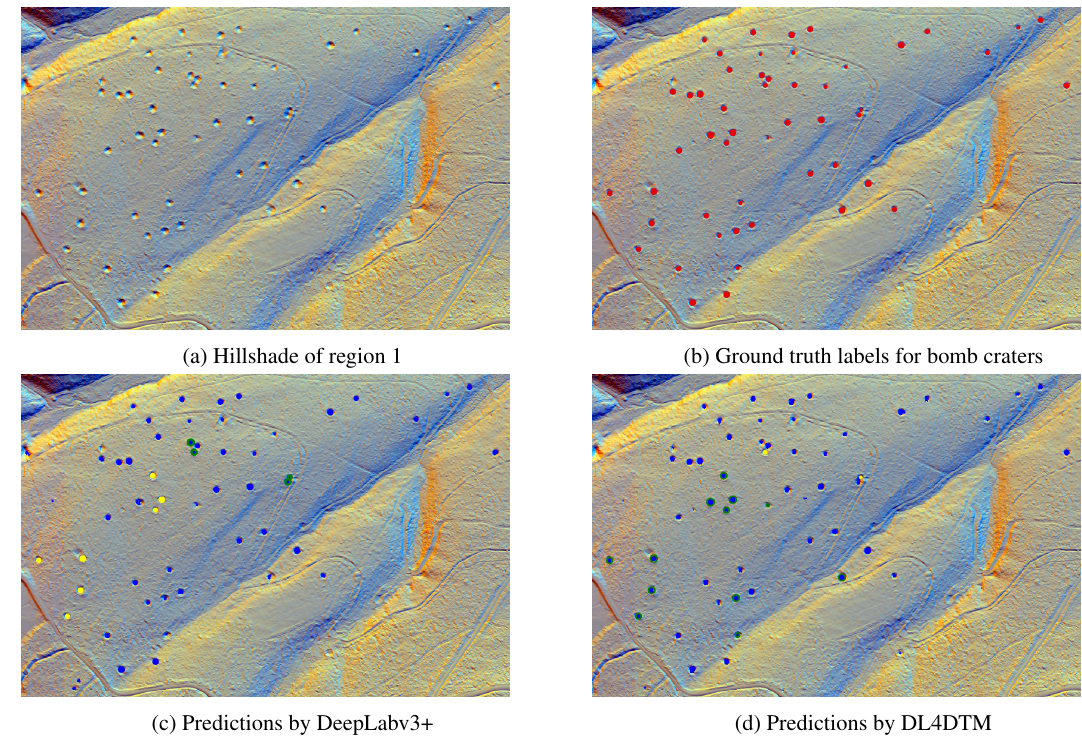
Figure 3. Region 1 containing bomb craters. In 3c and 3d, blue indicate correct predictions, yellow indicate bomb craters that were not detected by the models, the green circle indicate that the model made a better prediction than the other.